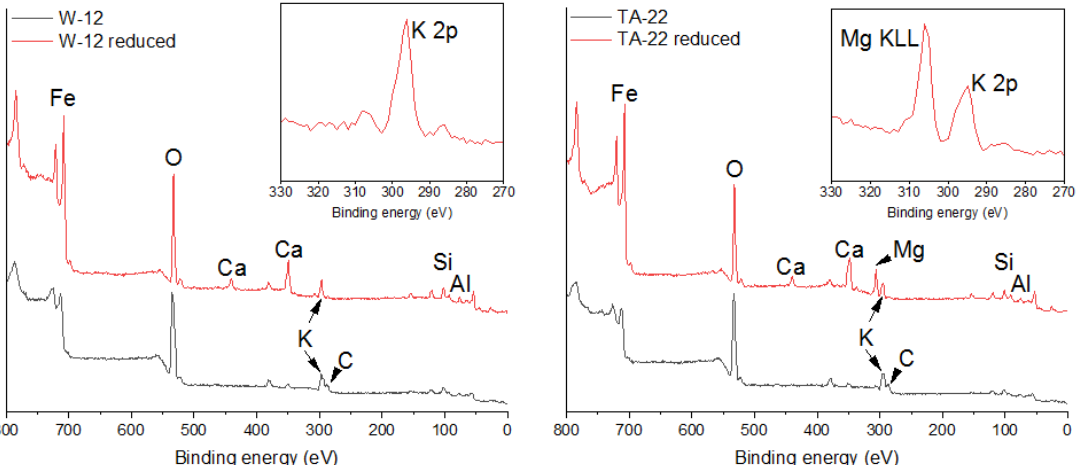
Figure 7. X-ray photoelectron survey spectra of samples W-12 ( left panel) and TA-22 ( right panel). The surface compositions before and after reduction in a hydrogen atmosphere are shown. The inserts in both panels represent blow-ups of the binding energy range taken from each survey spectrum after the reduction in hydrogen characteristic of the presence of potassium K 2p photoelectron peaks as well as magnesium Mg KLL Auger electron peaks.